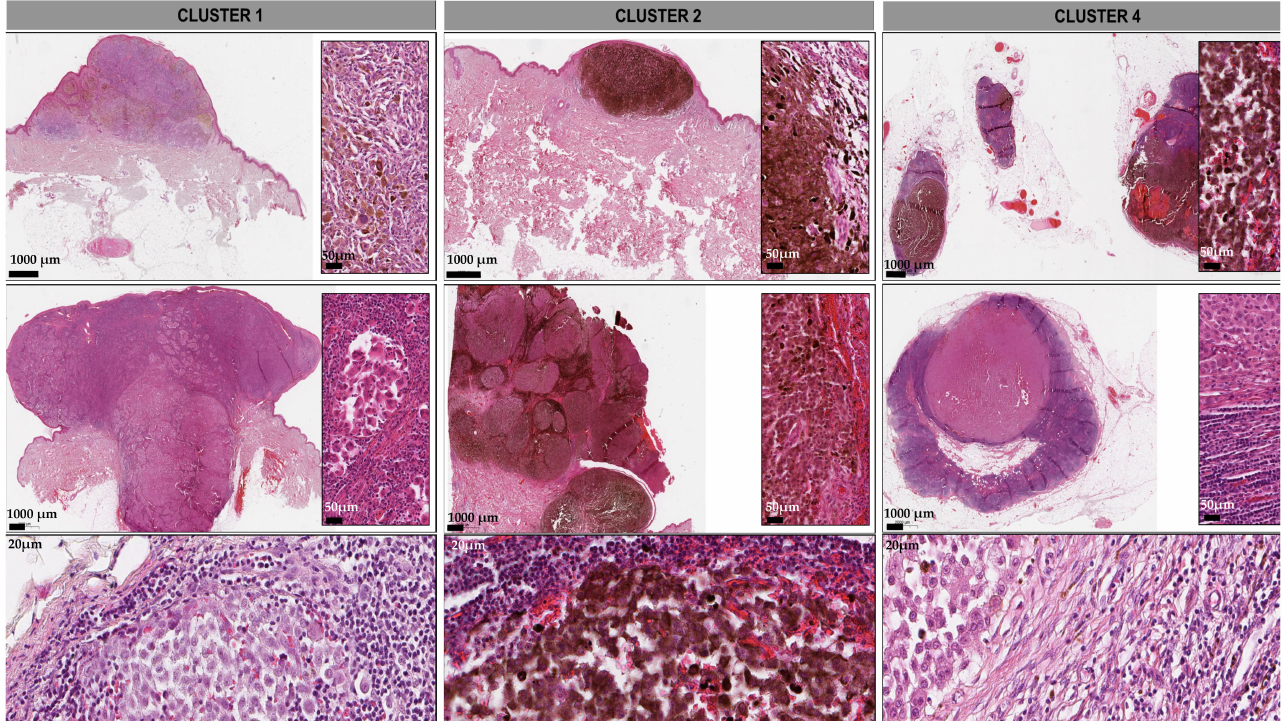
Figure 5. Histopathologic characteristics of the samples in sample cluster 1, 2 and 4. The image represents the spectrum of the morphology of the examined samples, as Cluster 1 involves vertical growth or de novo nodular melanomas displaying an anaplastic, fusiform or epithelioid phenotype (inserts). Additionally, a few metastases were also included exhibiting the same dedifferentiated morphology. In Cluster 2 , similar phenotypes were noted, with a pronounced intratumoral melanin pigmentation. Cluster 4 entailed the majority of the lymph node metastases. OM (optimal magnitude) 112 × ; HE (hematoxylin-eosin) staining; inserts indicate magnified areas with scale bar 50 µ m (Table